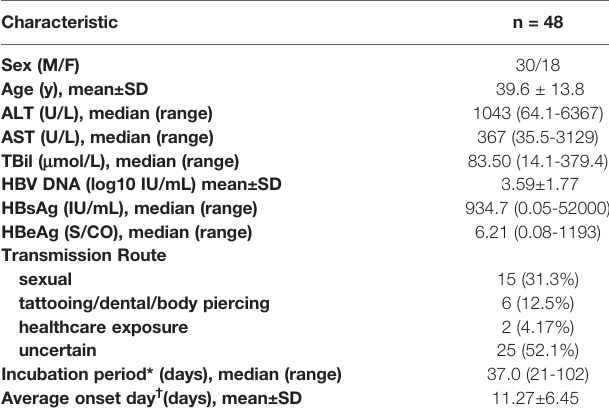
TABLE 1 | Baseline Clinical and Virological